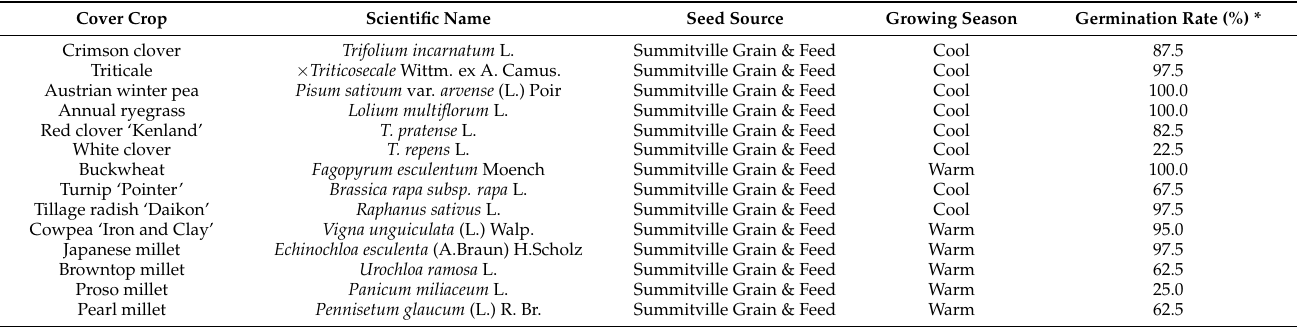
Table 1. List of cover crops used for in vitro screening for